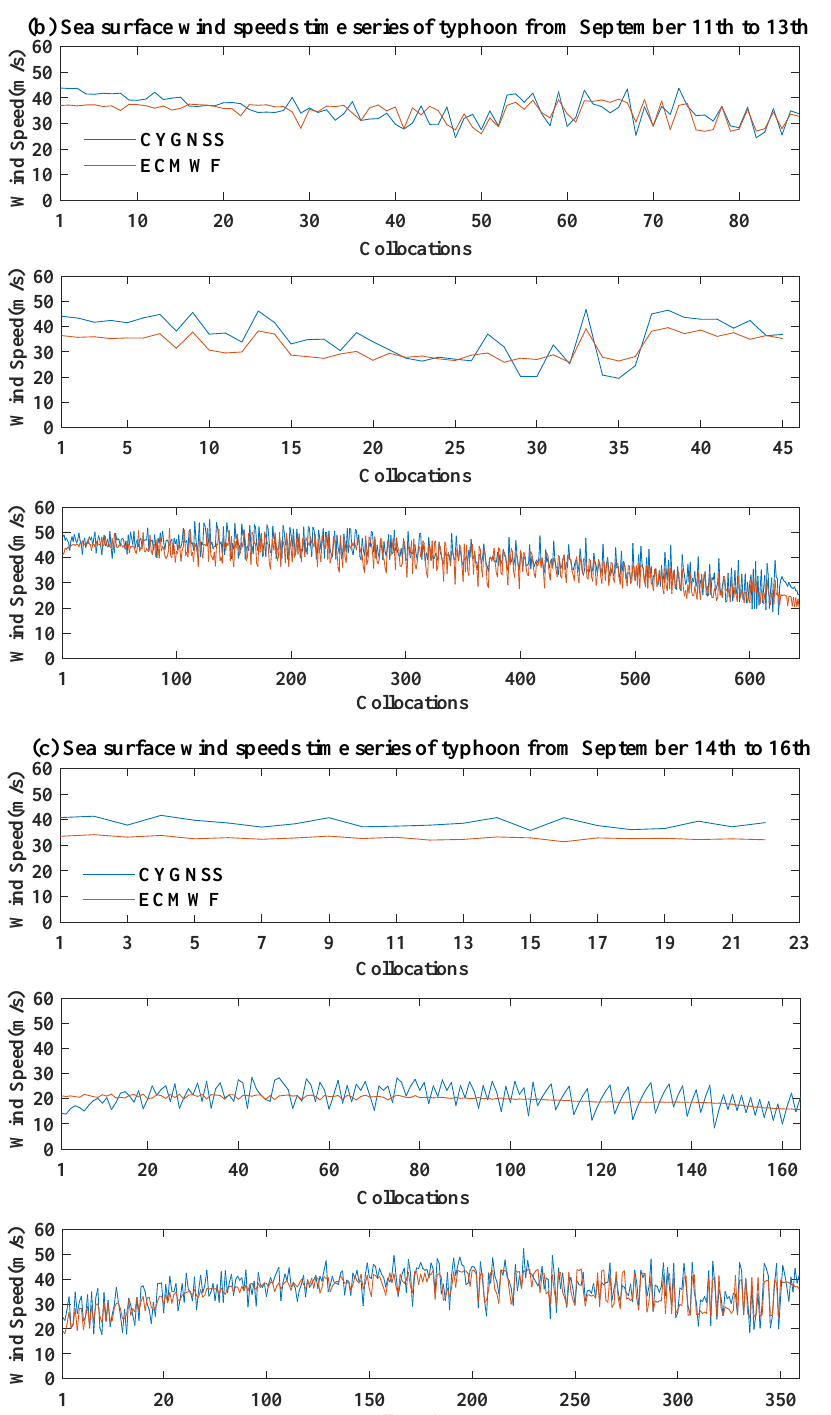
Figure 5. Comparison of sea surface wind speed between CYGNSS and ECMWF reanalysis data. ( a ) From September 8th to September 10th, ( b ) from September 11th to September 13th; ( c ) from September 14th to September 16th. The x -axis represents the number of sample points per day and the y -axis represents the wind